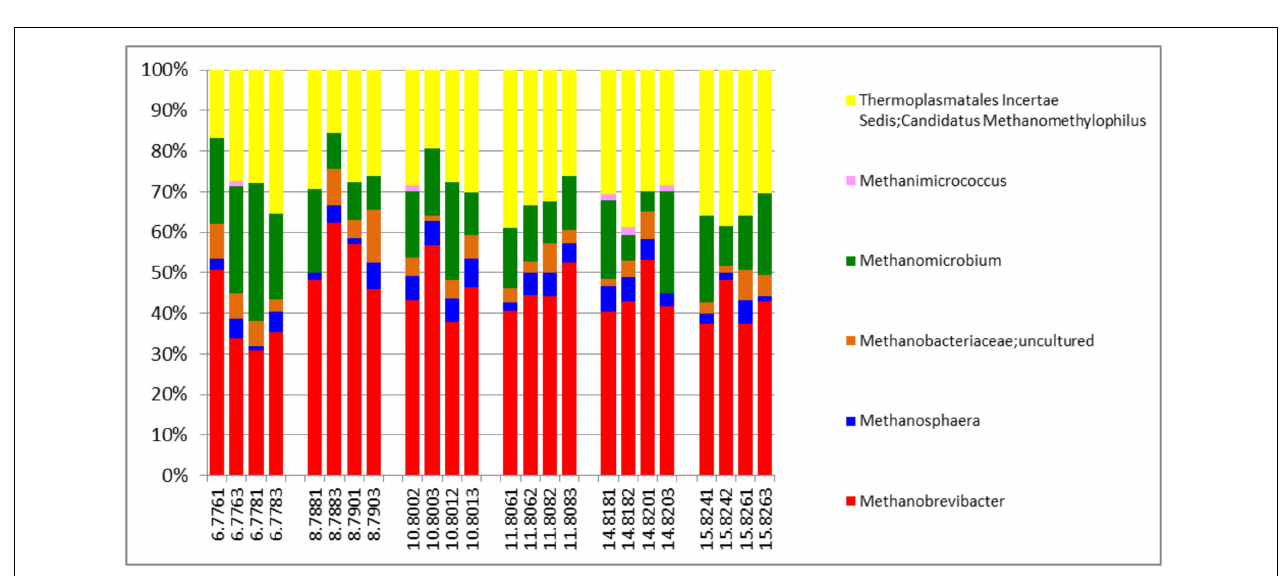
FIGURE 4 | Taxonomic distribution of the archaea community in the V4 region extracted from total rRNA analysis, of solid-phase rumen contents of 6 cattle, 2 samples from each, analyzed in